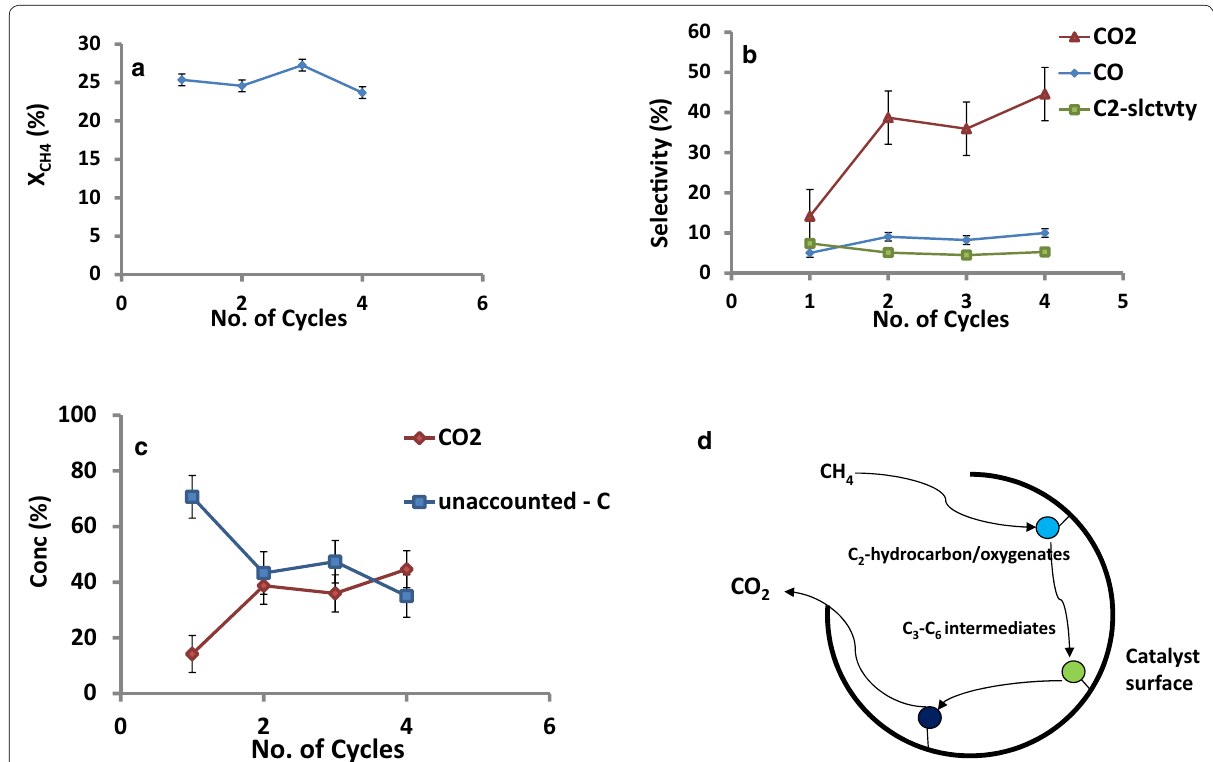
Fig. 7 Effect on catalyst recyclability on ( a ) conversion of methane with multiple cycles involving reactivation of catalysts via flow of pure oxygen, ( b ) selectivity for end products, and ( c ) carbon balance under the experimental conditions 650 ºC, 0.8 L/min, 10 g catalyst, and CH 4 :O 2 reactivation via O 2 at 0.8 L/min and He -1 L/min; ( d ) schematic representation of secondary collision of intermediate products undergoing complete oxidation into CO